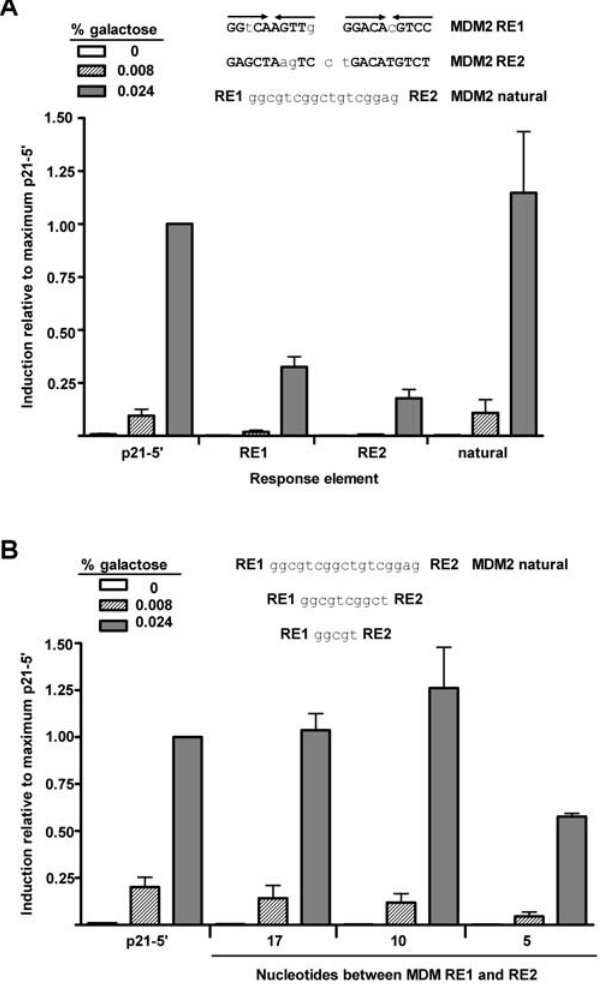
Figure 2. Weak REs can function synergistically when separat- ed by a spacer. (A) To ascertain if p53 functions from the two full-site REs of MDM2 independently or if the REs interact, p53 transactivation from the isolated REs, as well as the natural MDM2 RE containing a 17 nucleotide spacer were evaluated. Isogenomic diploid yeast strains containing the p21-5 9 and MDM2 REs, as indicated, were grown in increasing concentrations of galactose to induce p53 protein to basal, moderate and high levels of expression. The ability of WT p53 to transactivate from RE sequences was measured by a luciferase assay 24 hours after inoculation into the galactose supplemented media. Induction from each RE was compared relative to the ability of p53 to transactivate from the p21-5 9 RE at 0.024% galactose and is depicted as the mean and standard error of measurement (SEM) of 6 independent experiments. The average light units/ m g protein from p21-5 9 at 0.024% galactose was 2.1 million. Solid arrows over the sequences indicate a J -binding site. (B) Impact of reducing the spacer to 10 and 5 nucleotides. The average light units/ m g protein for p21-5 9 at 0.024% galactose was